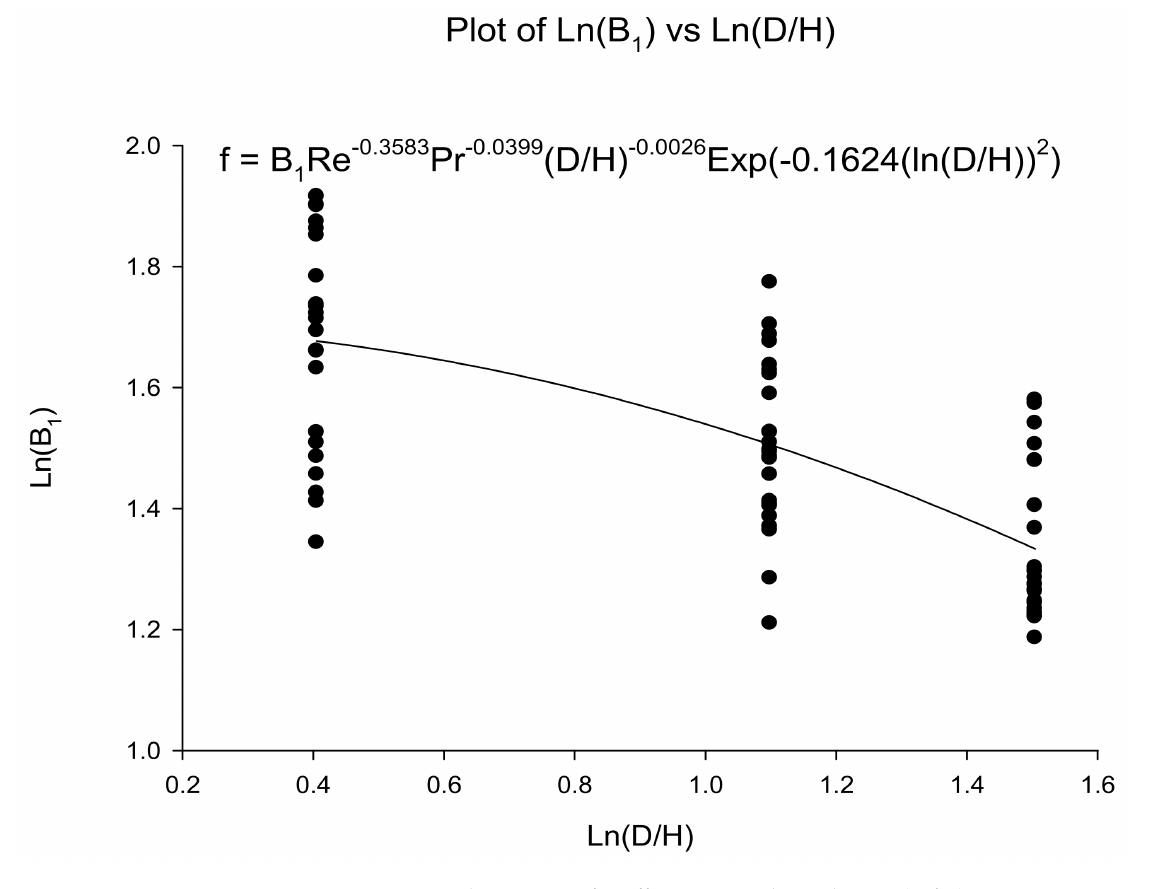
Figure 9. Experimental Variation of coefficient B1 and Depth ratio (D/H).